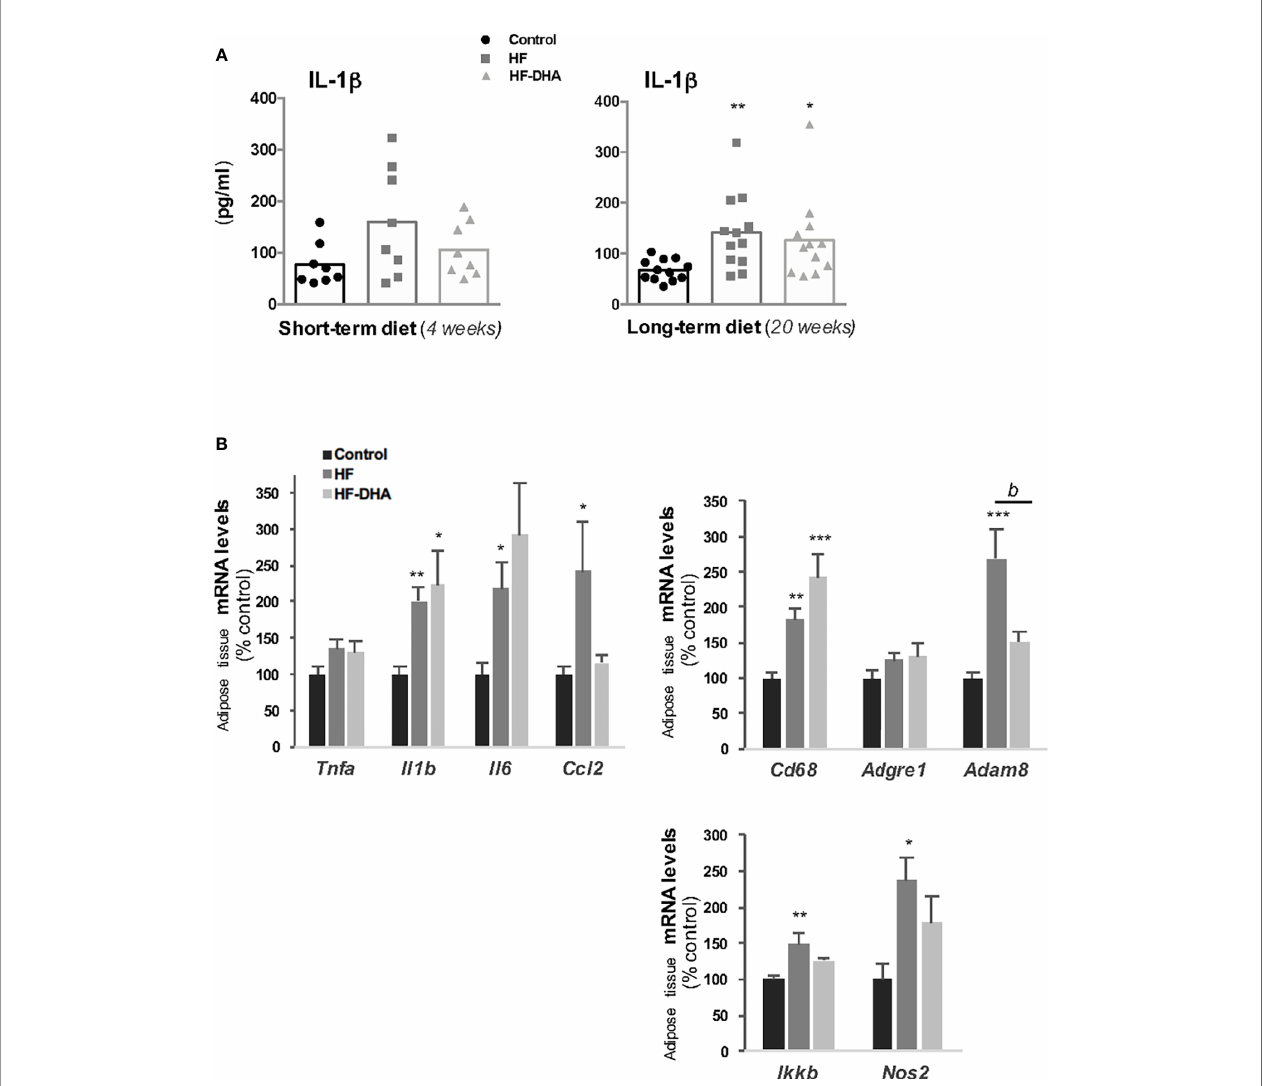
FIGURE 2 | Characterization of peripheral in fl ammation in rats after 20 weeks of high-fat diets. (A) Circulating levels of the pro-in fl ammatory cytokine interleukin-1 b (IL-1 b ) in rats fed control, HF or HF-DHA diets for 4 and 20 weeks. Levels of IL-1 b were assayed by ELISA as described in Materials and Methods. The bar height re fl ects the mean and symbols re fl ect individual animals. (B) Transcript levels of different in fl ammatory markers in sub-cutaneous adipose tissue after 20 weeks of control or HF diets. Transcript levels were determined by real time PCR, relative levels of genes were normalized to the one of Cyclophilin and expressed as % of the control group. Data are means ± SEM from 11-12 (A) or 8 (B) rats and were analyzed by non-parametric one-way ANOVA (Kruskal-Wallis test) followed by Dunnett ’ s multiple comparison test. * P ≤ 0.05; ** P ≤ 0.01; *** P ≤ 0.001 vs control. b P ≤ 0.01 between HF and